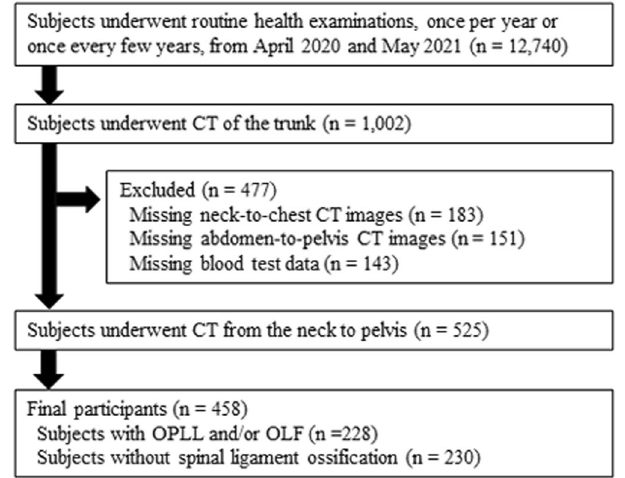
Figure 1. Flow chart of study participants. CT, computed tomography; OLF, ossification of the ligamentum flavum; OPLL, ossification of the posterior longitudinal